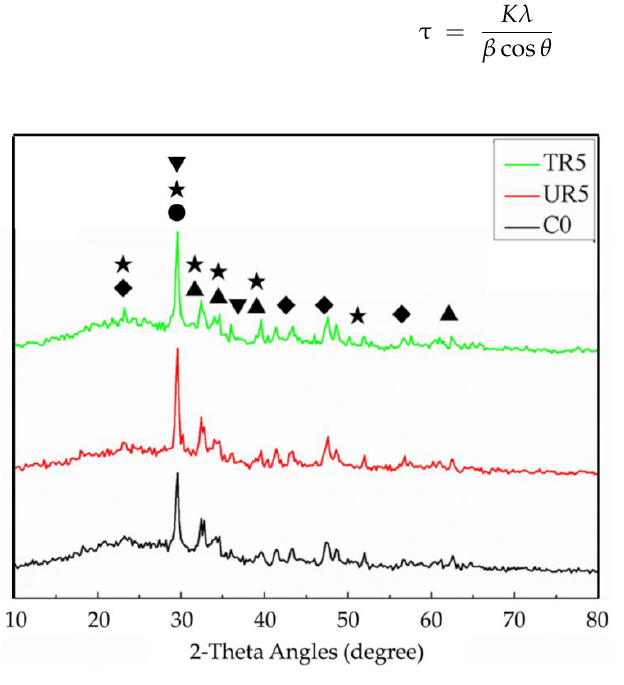
Figure 10. XRD patterns of the paste samples ( ★ : C 3 S; ▲ : C 2 S; ▼ : CaCO 3 ; ◆ : C-H; ●: C-S-H.). Table 3. The FWHMs of the C0, TR5, and UR5.